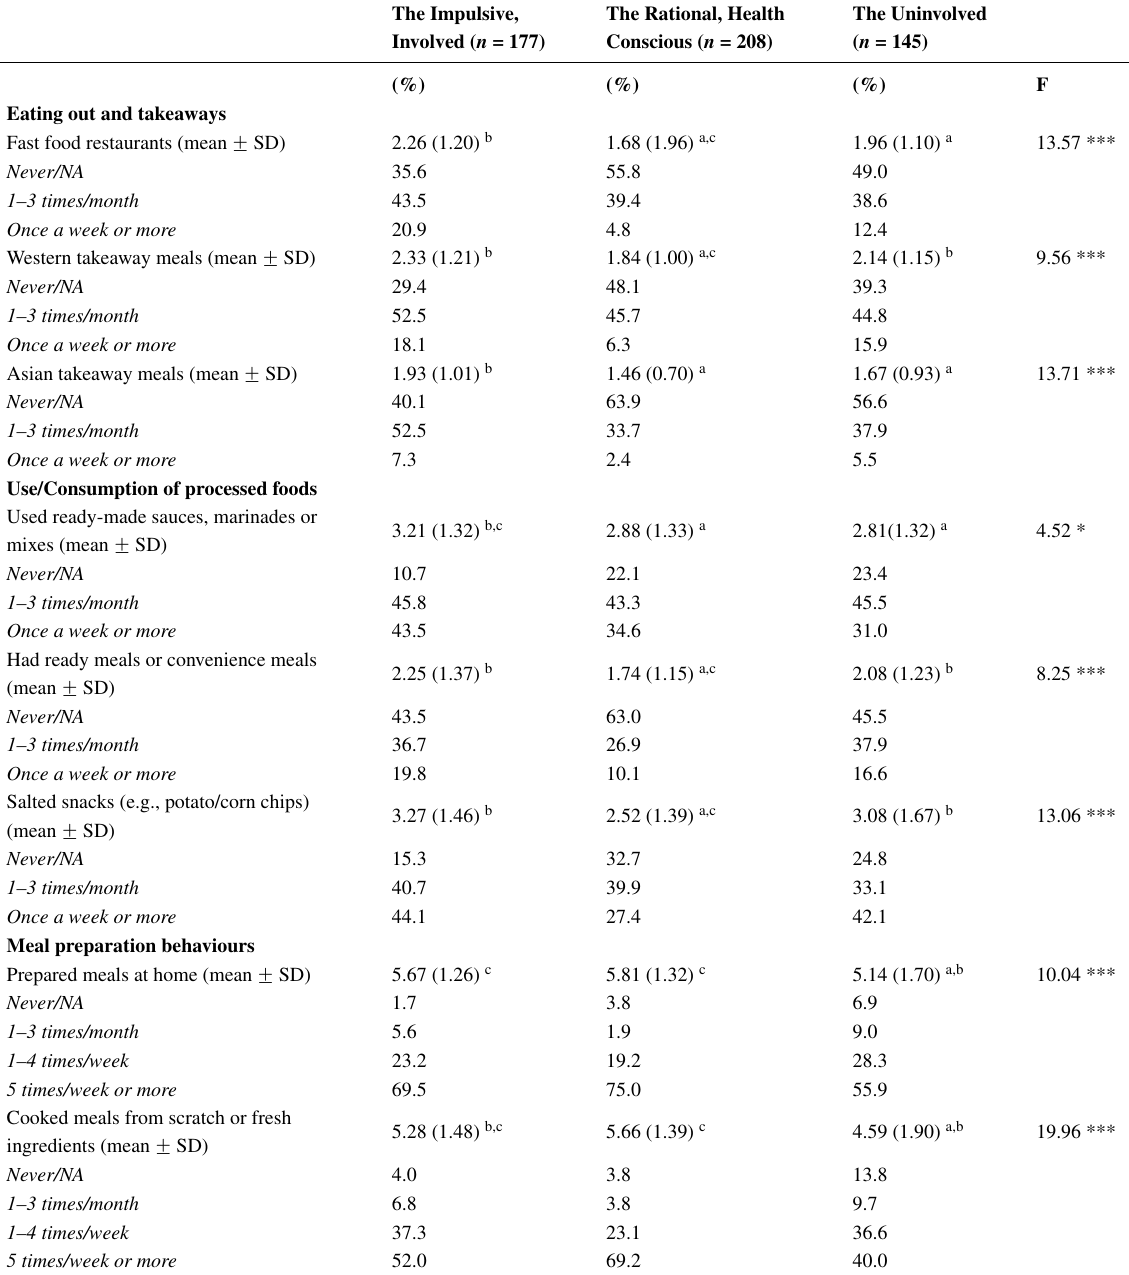
Table 3. Dietary behaviours and meal preparation practices of the